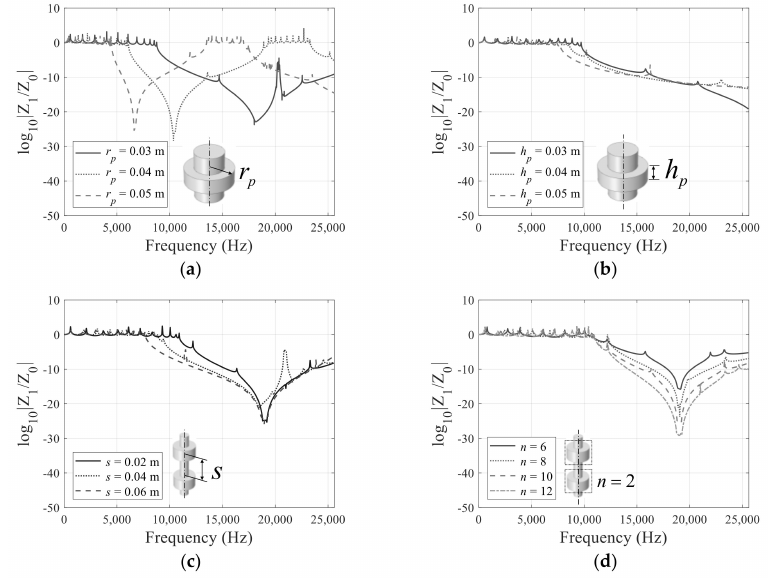
Figure 6. Frequency response analysis results for each parameter of straight beam with repeated cylinders of the metamaterials for the longitudinal wave: ( a ) h p = 0.02 m, n = 10, d = 0.02 m ( b ) r p = 0.03 m, n = 10, d = 0.02 m ( c ) r p = 0.03 m, h p = 0.02 m n = 10 ( d ) r p = 0.03 m, h p = 0.02 m d = 0.02 m.